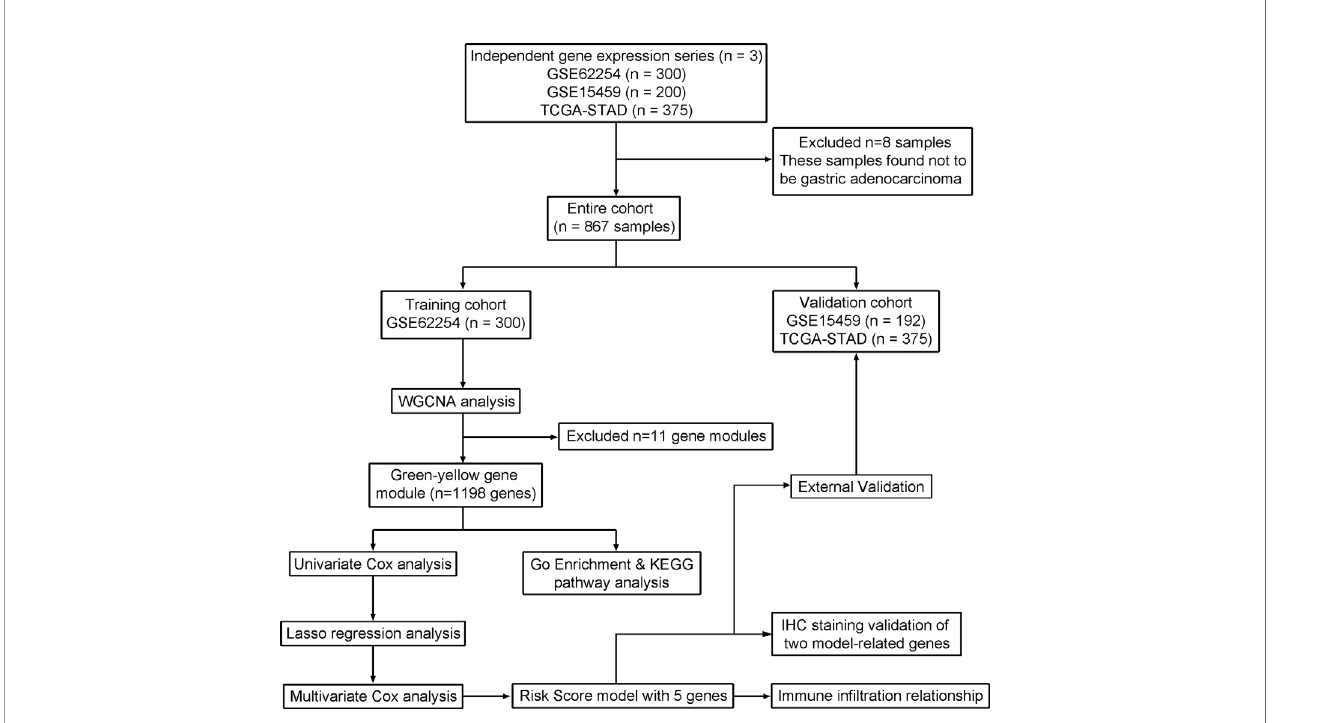
FIGURE 1 | Flow chart of data acquisition, analysis, and